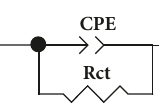
Figure 9: Equivalent circuit used to model the experimental EIS data.